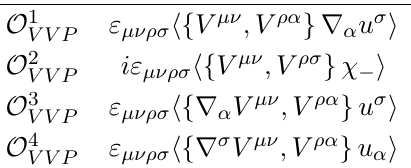
Table 2 . Full list of O j operators [66], containing those ( j = 1 ; 2 ; 3 ; 5 ; 6) that contribute to the V JP V (cid:0) (cid:13) (cid:0) (cid:30) a vertex.